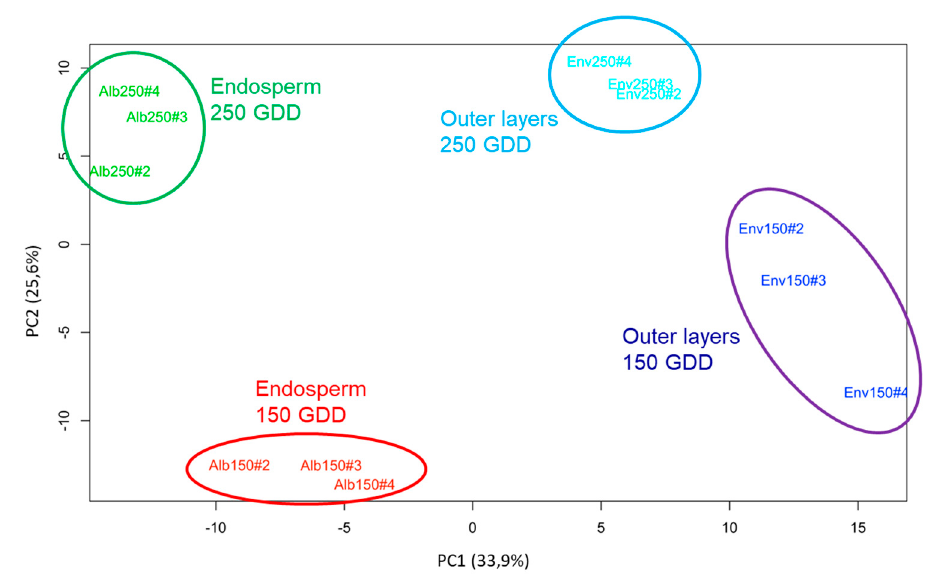
Figure 2. Principal component analysis (PCA) performed using the relative amounts of cell wall proteins (CWPs) for both parts of the wheat grain and at the two developmental stages (150 and 250 GDD). Individual maps of the biological replicates (red: endosperm samples at 150 GDD, green: endosperm samples at 250 GDD, dark blue: outer layers samples at 150 GDD, light blue: endosperm samples at 250 GDD) along principal components 1 and 2.